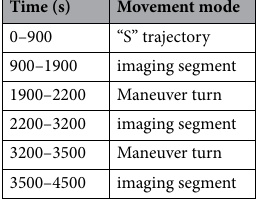
Table 1. The flight process